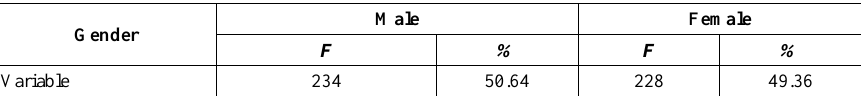
Table 1. Distribution of university students by